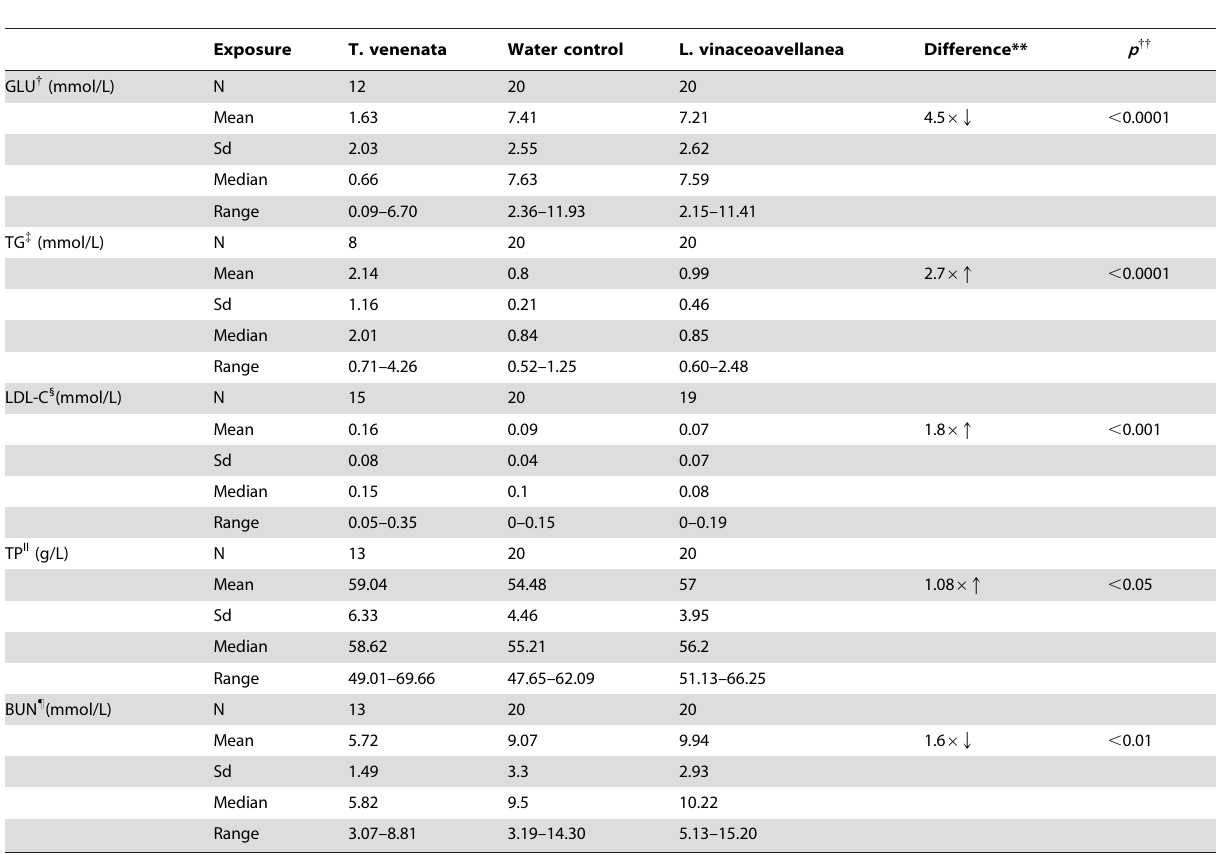
Table 2. Mean serum biochemical determinations * two hours after feeding mice with extracts (2000 mg/Kg B.W.) of Trogia venenata , Laccaria vinaceoavellanea , or water